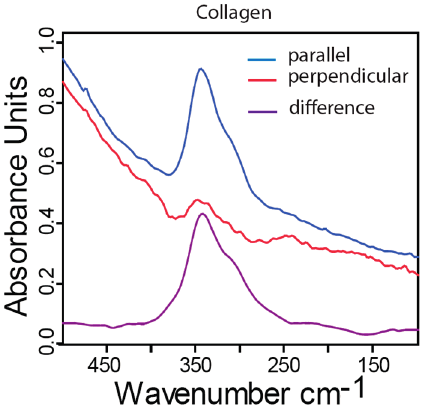
Figure 5. Far-IR dichroism measurements of fully demineralized fibrolamellar bovine bone showing the absorbance parallel ( blue ) or perpendicular ( red ) to the long axis of the bone. The violet spectrum denotes the difference between these two spectra.